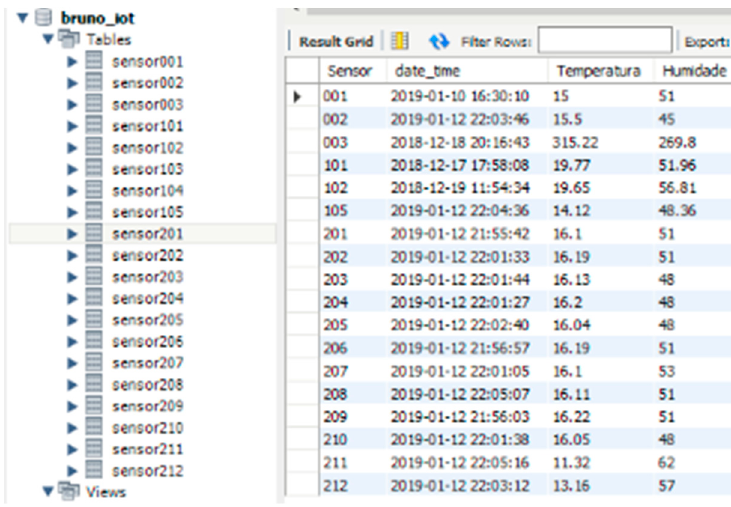
Figure 7. Flash Web Server developed in Python.